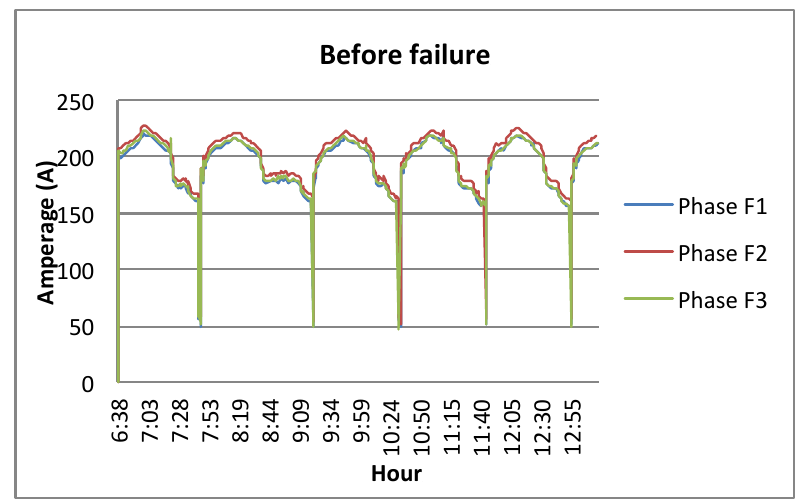
Figure 4. Absorption trend of the old motor before failure.